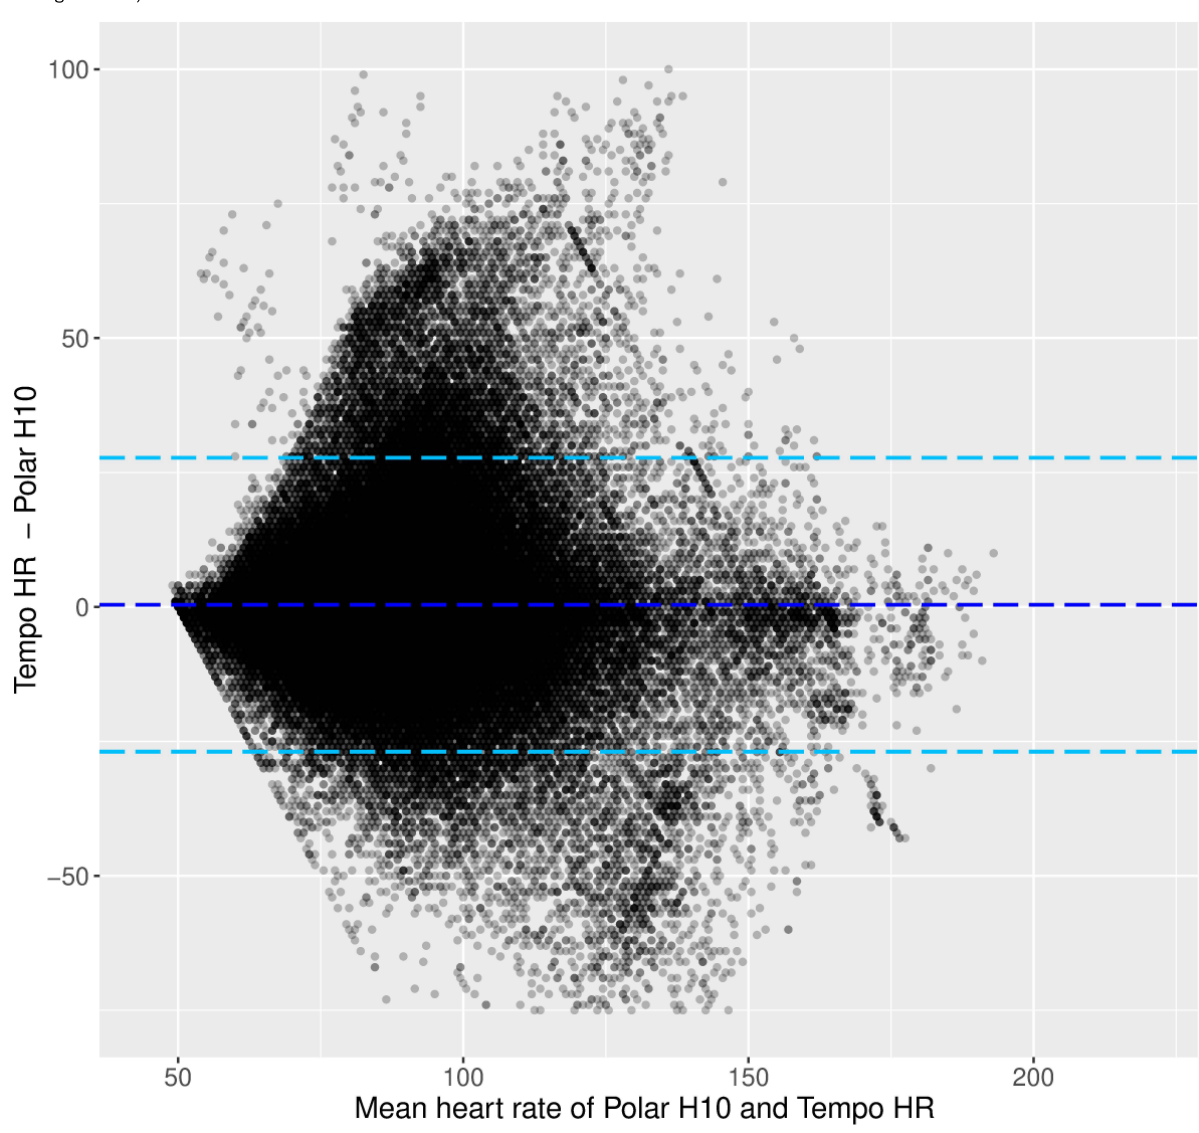
Figure 6. Free-living phase: Bland-Altman plot between the heart rate data from the Polar H10 and the Tempo HR. Light blue dotted lines show the limits of agreement, and the dark blue dotted line shows the mean of the difference. HR: heart